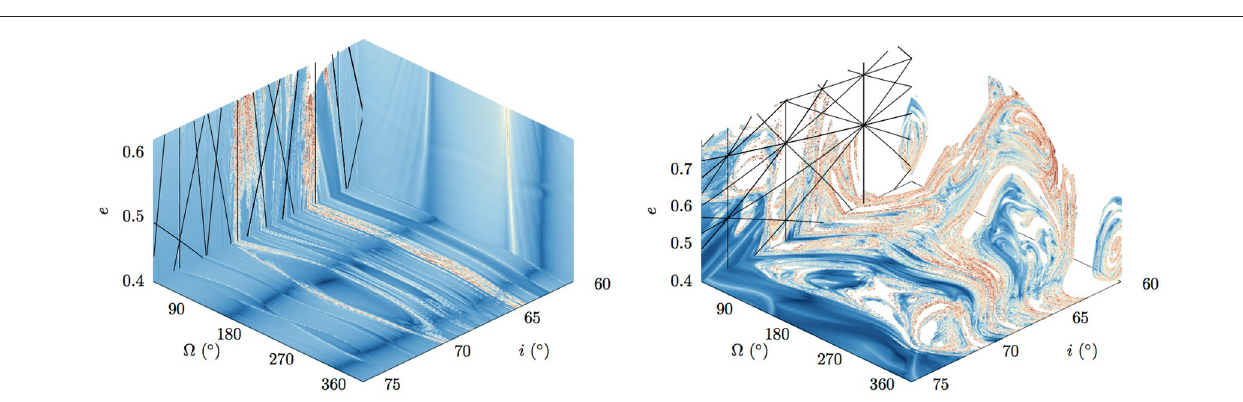
18,600 km (Left) and a 29,600 km (Right) highlight a bifurcation phenomena. The resonant manifolds = =